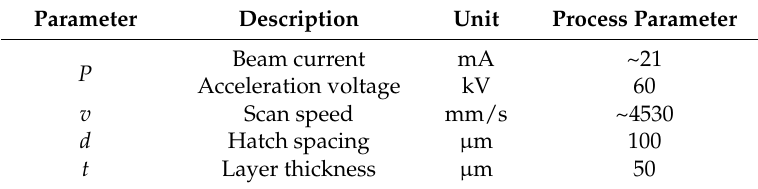
Table 3. Overview of the energy-relevant process parameters used to build all samples; EBM process.